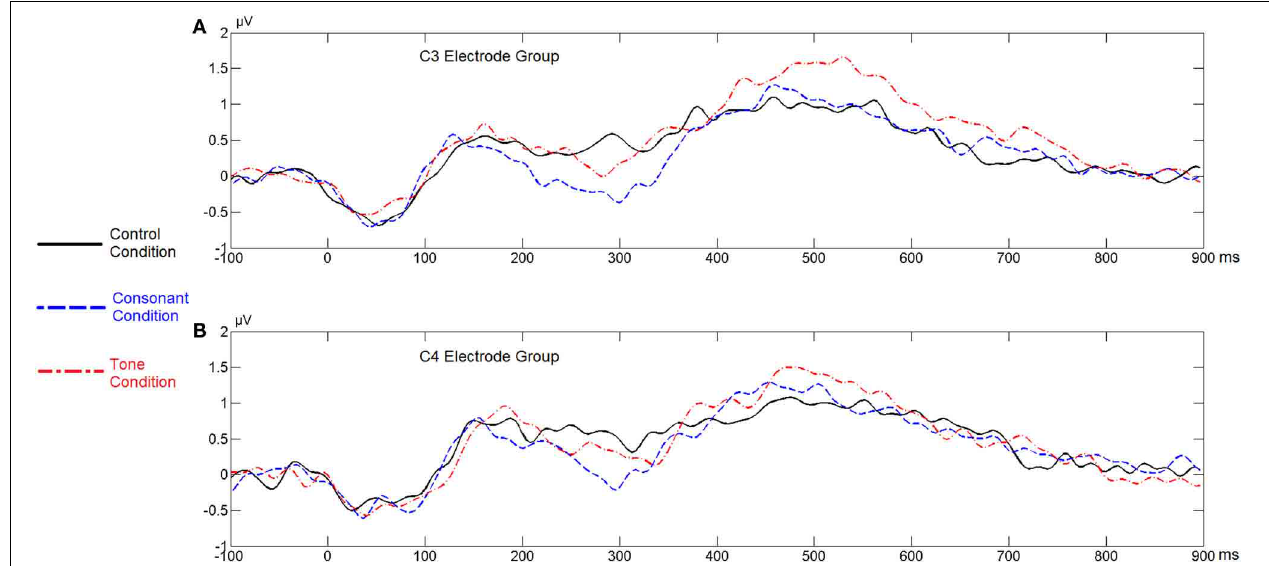
FIGURE 12 | Average ERP waveforms of the F3 and F4 electrode groups in Experiment 3. (A) C3 electrode group; (B) C4 electrode group.